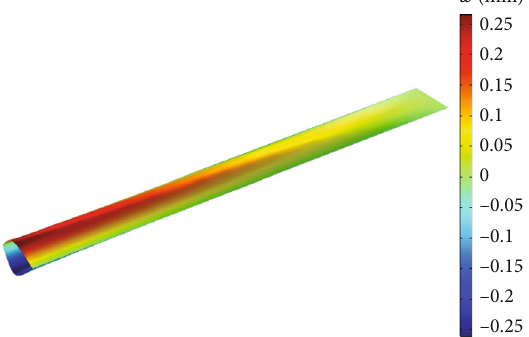
Figure 14: Displacements of aperture under 2 MPa injection